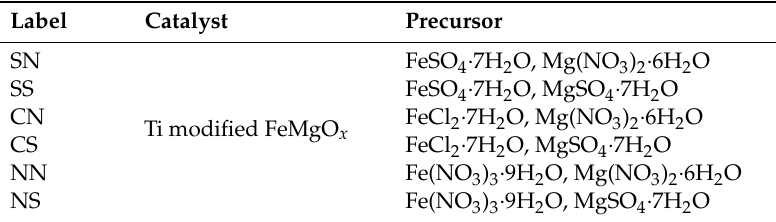
Table 1. Titanium modified FeMgO x catalysts with di ff erent